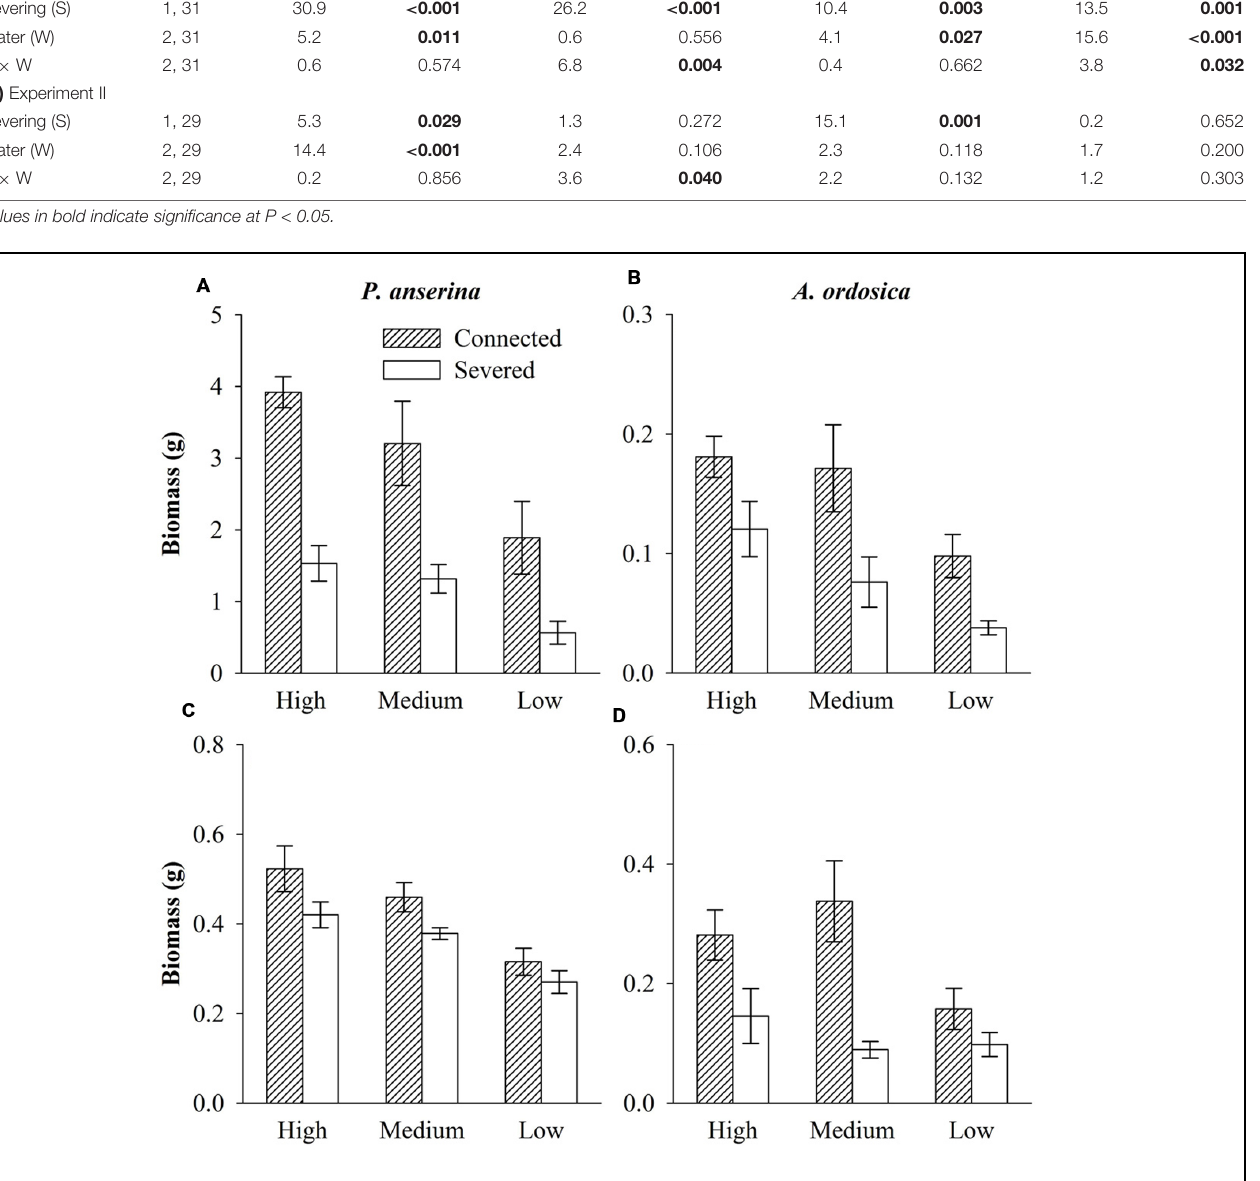
of A. ordosica was probably attributable to the uptake of the translocated [ 15 N] and [D] that were released by the recipient ramets into the